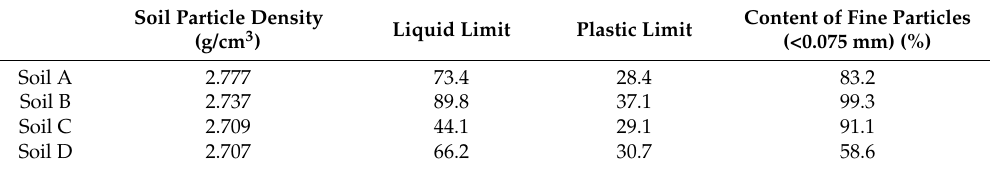
Table 1. Physical properties of the dredged soils.